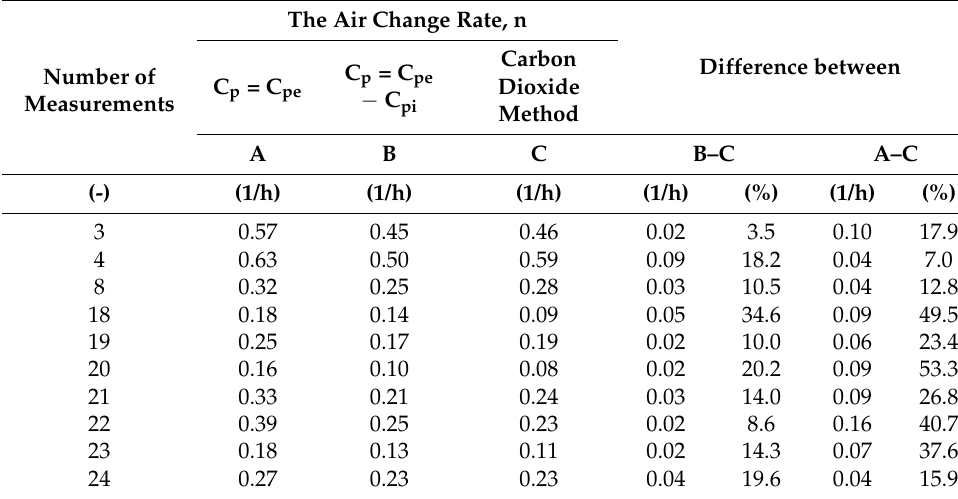
Figure 12. Comparison of air change rate values without considering the influence of openings C p = C pe with considering the effect of openings C p = C pe − C pi and calculation based on experimental measurements of carbon dioxide for lower wind speed v = 1.1–4.1 m/s. Table 3. Calculated differences and percentage differences in air exchange rate determined by different methods—higher wind